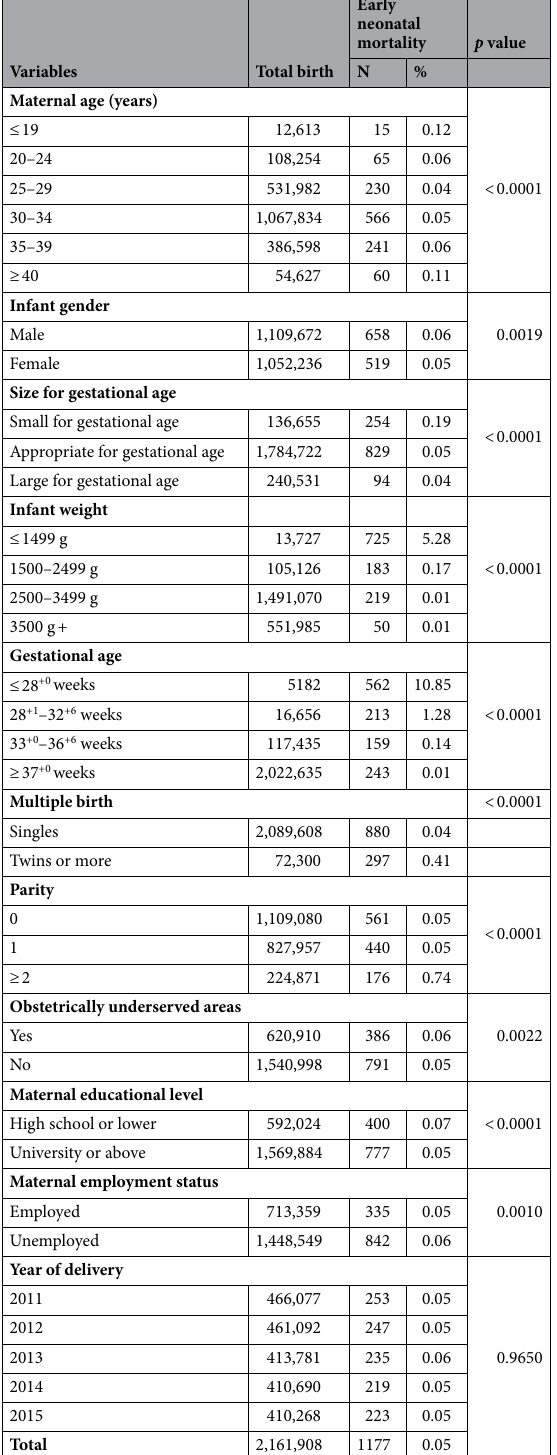
Table 1. Characteristics of the study